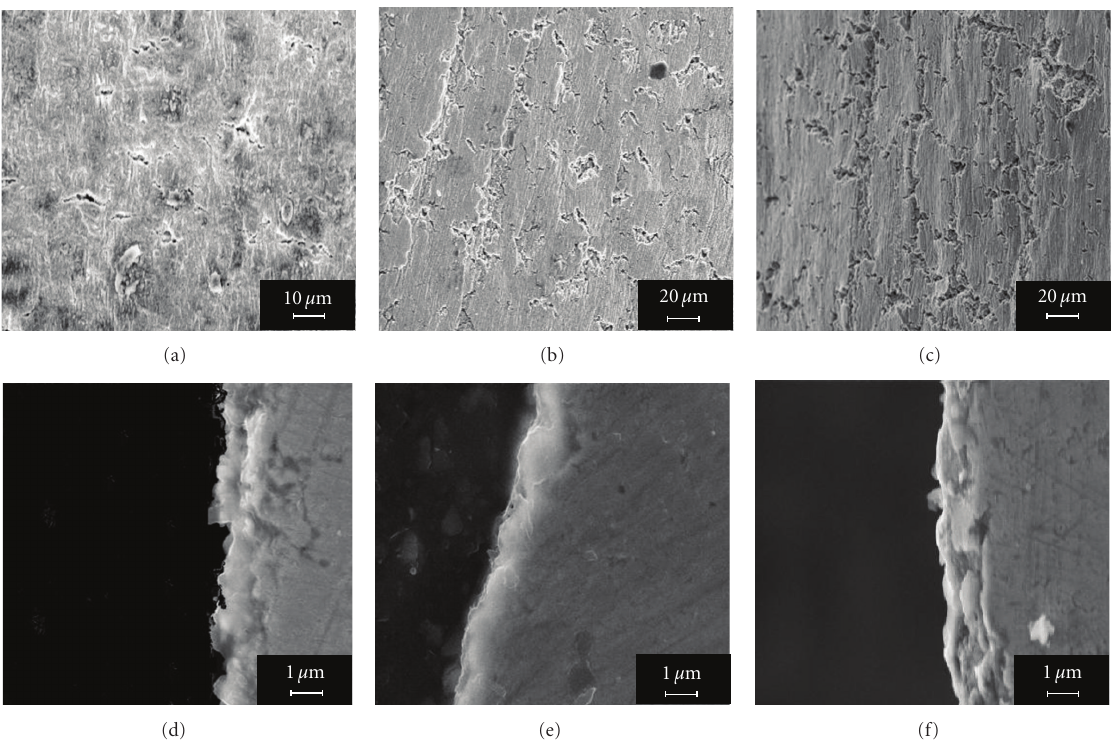
Figure 6: SEM images of oxidation film micromorphology. (a) the surface morphology of oxidation film without deformation and forming at 900 ◦ C in air; (b) the surface morphology of oxidation film forming at 900 ◦ C in air, and then deformation degree 5%, strain rate 10 − 3 s − 1 at 900 ◦ C in vacuum environment; (c) the surface morphology of oxidation film forming at 900 ◦ C in air, and deformation degree is 10%, strain rate 10 − 3 s − 1 at 900 ◦ C in vacuum environment; (d) the section plans of undeformed oxidation film; (e) the section plans of deformed oxidation film; (f) the section of surface oxidation film forming at 900 ◦ C in air after the deformation in vacuum environment: (i) epoxy resin, (ii) oxide film, and (iii) metal